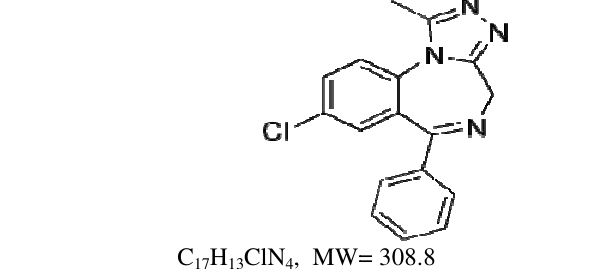
Figure 1. 8-Chloro-1-methyl-6-phenyl-4H